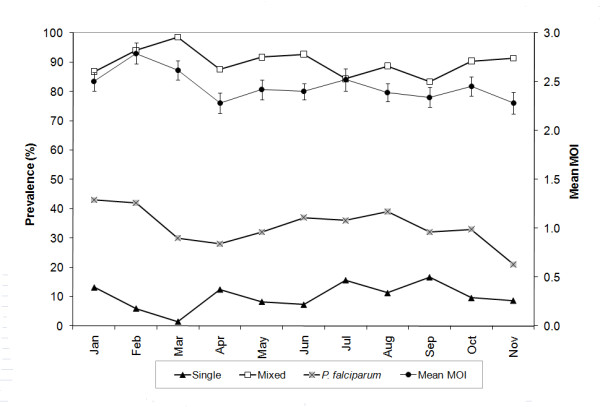
Monthly prevalence of Plasmodium falciparum infections, indicating the proportions of single and mixed infections and mean multiplicity of infection (MOI). Prevalence of mixed infections was high, with mean MOI consistently above 2.0 throughout the year. Whiskers represent standard error values. December data were excluded because of insufficient sample size (n = 11; but all were mixed infections).